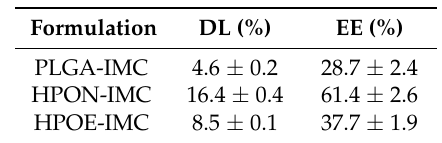
Table 4. DL and EE of the new prepared